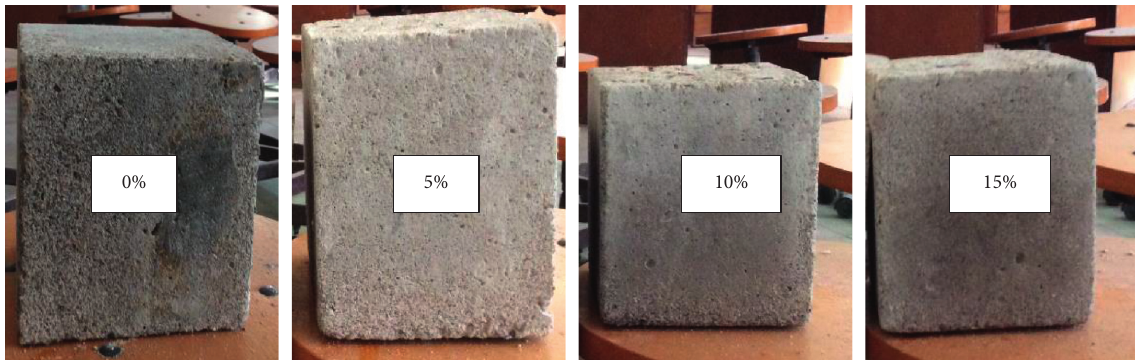
Figure 2: PPC-WPPA concrete deterioration in 2% sulfuric acid